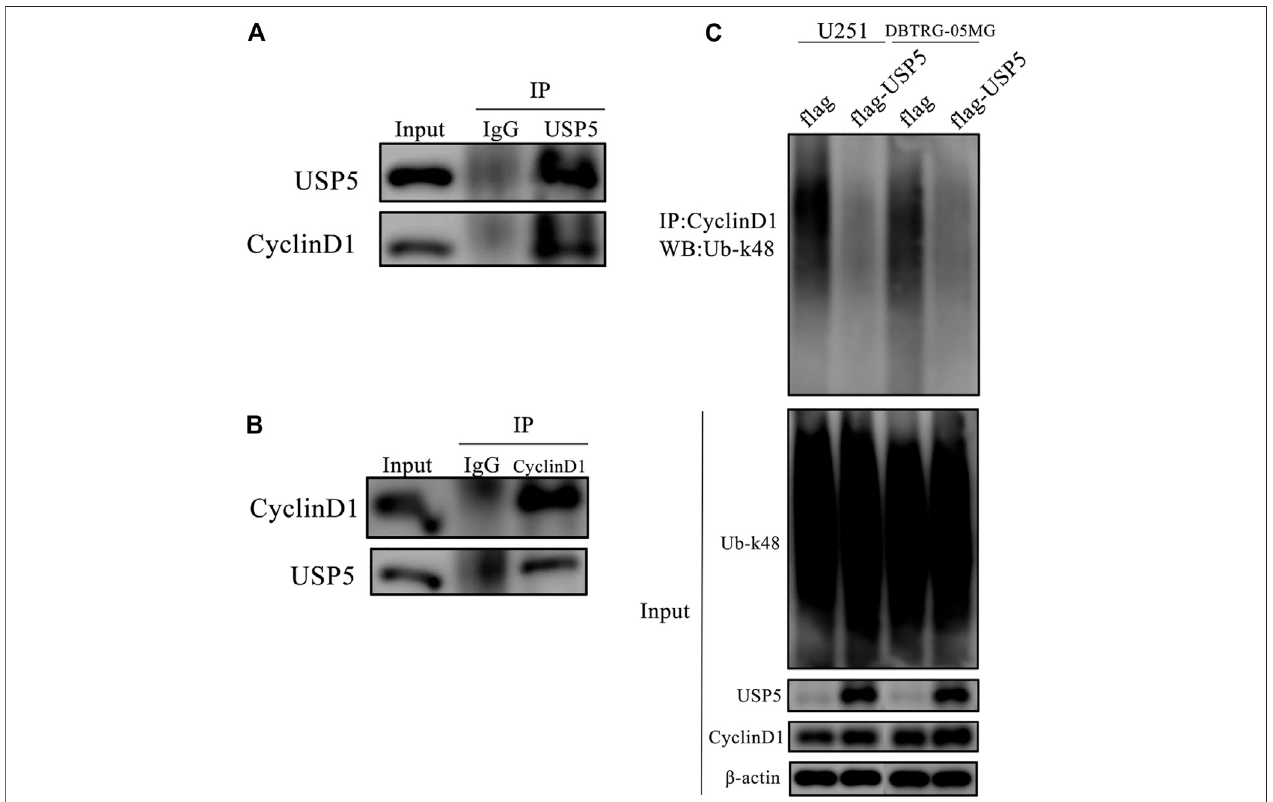
FIGURE 4 | USP5 directly interacted and deubiquitinated and CyclinD1 (A, B) USP5 (A) or CyclinD1 (B) was immunoprecipitated from U251 cells, respectively. Control immunoprecipitations were with nonspeci fi c IgG, followed by western blotting of the precipitated proteins with antibodies for USP5 and CyclinD1 (C) CyclinD1 was immunoprecipitated from U251 and DBTRG-05MG cells stably expressed empty vector ( fl ag) or USP5 overexpression ( fl ag-USP5), respectively, followed by western blotting of the precipitated proteins with the antibody speci fi cally for k48-linked ubiquitin (Ub-k48).